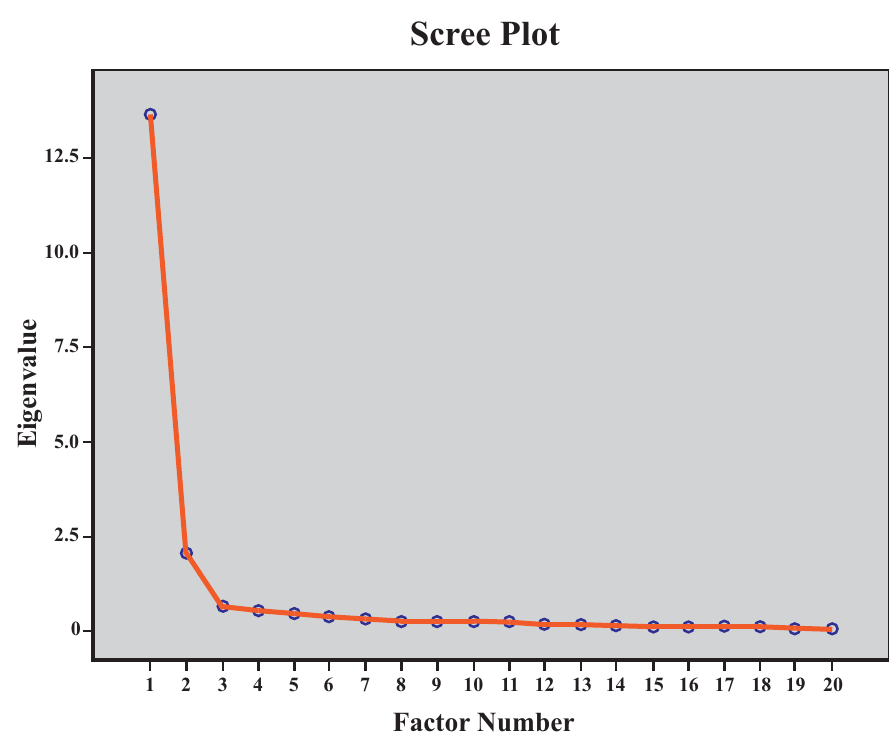
Fig 2. Exploratory factor analysis. Scree plot of eigenvalues form the 20-item modern standard Arabic version of Lower Extremity Functional Scale (LEFS-MSAr).